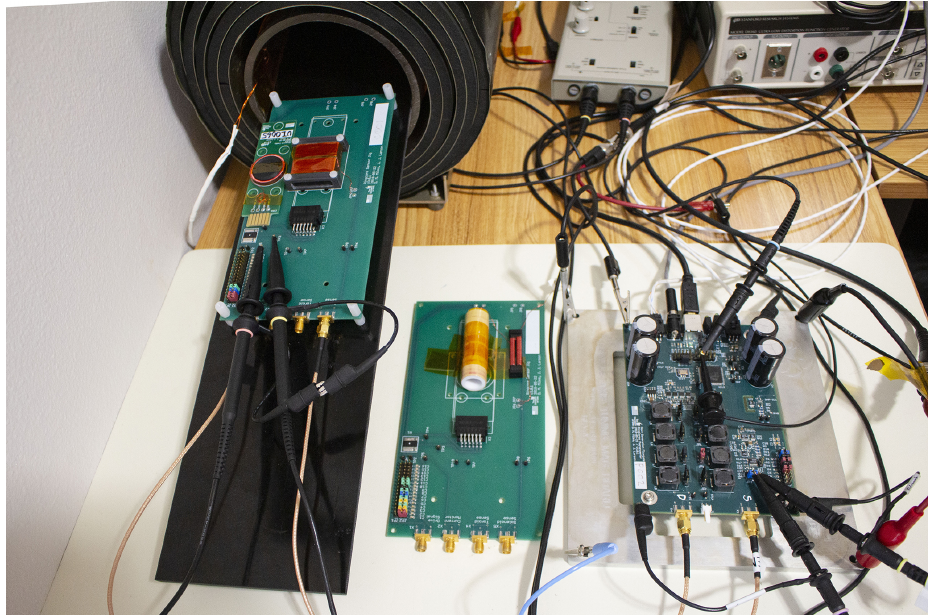
Figure 5. Experimental setup used to characterize core noise performance: five-layer MuMETAL shield with embedded solenoid, test fixtures for 1in. ring and racetrack cores, and single-axis benchtop magnetometer electronics.